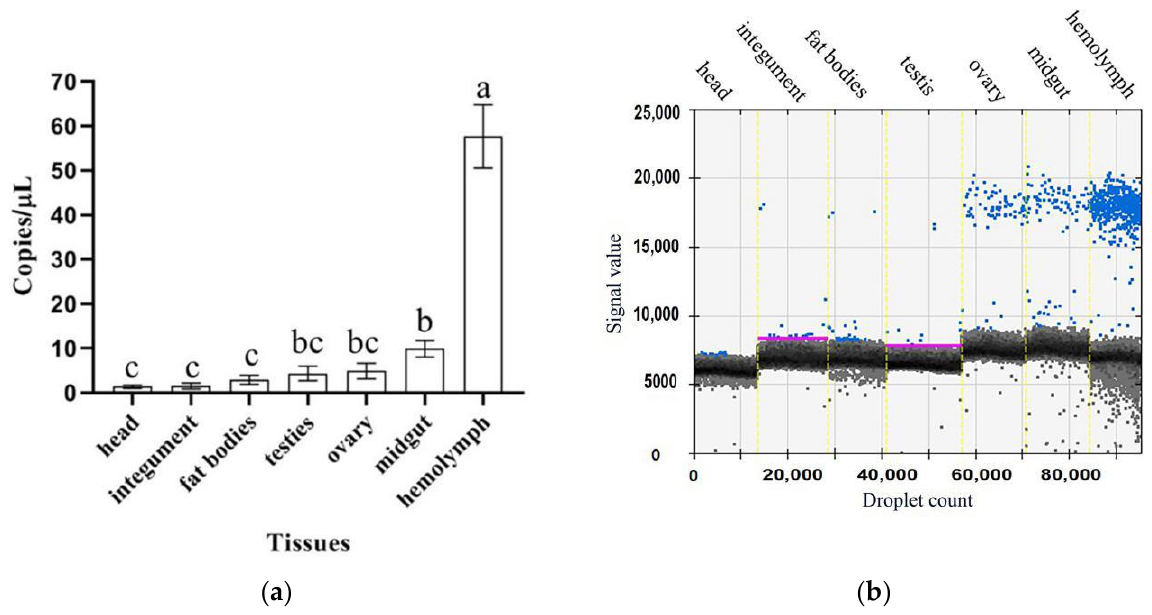
Figure 6. Expression levels of CmdsRNase in various tissues of C. medinalis adults. ( a ) Histogram. ( b ) Droplet generation diagram. Blue and black dots indicate positive and negative, respectively. Each bar represents the mean ± SD. Different letters above the bars indicate significant differences at p < 0.05 based on Duncan ’ s test.